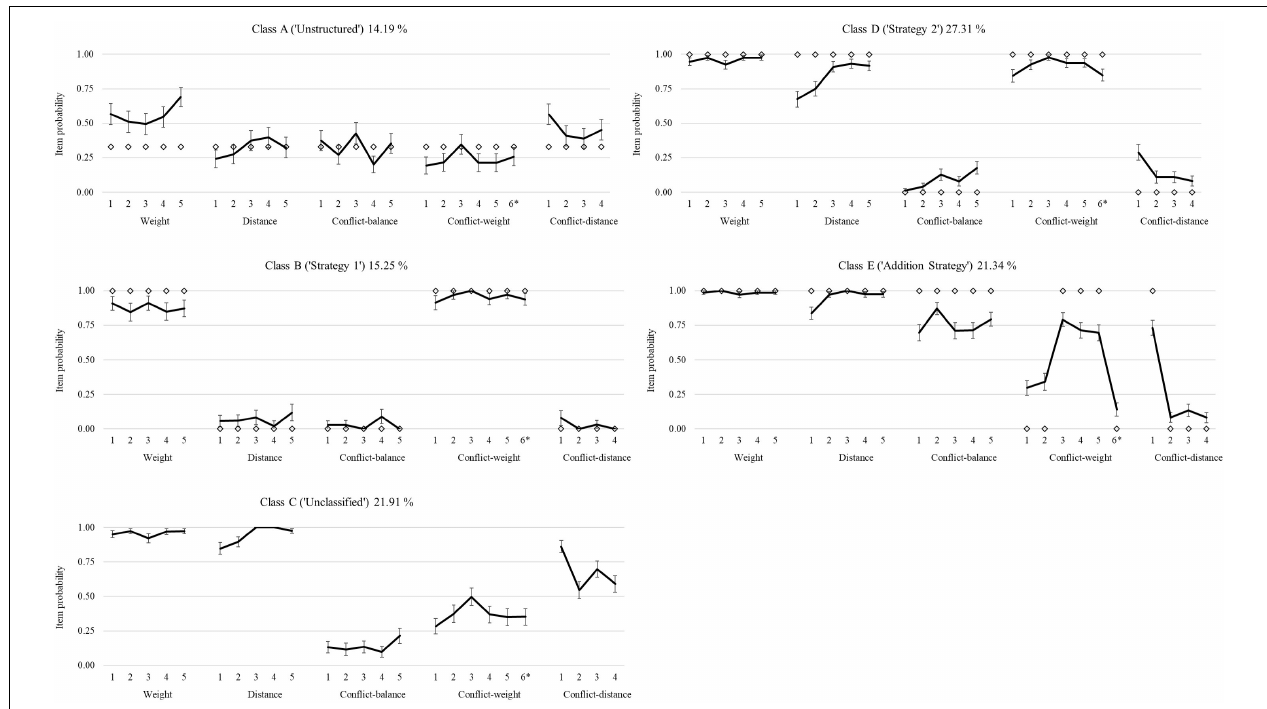
FIGURE 3 | Item probabilities for the six classes of the latent transition analysis (LTA), with the corresponding strategy and percentage of usage at pretest, and corresponding 90% confidence intervals. Items were distance, conflict-weight, conflict-distance, and conflict-balance; each had five items. *Note that item 5 of conflict-distance was digitized incorrectly and was a conflict-weight item.